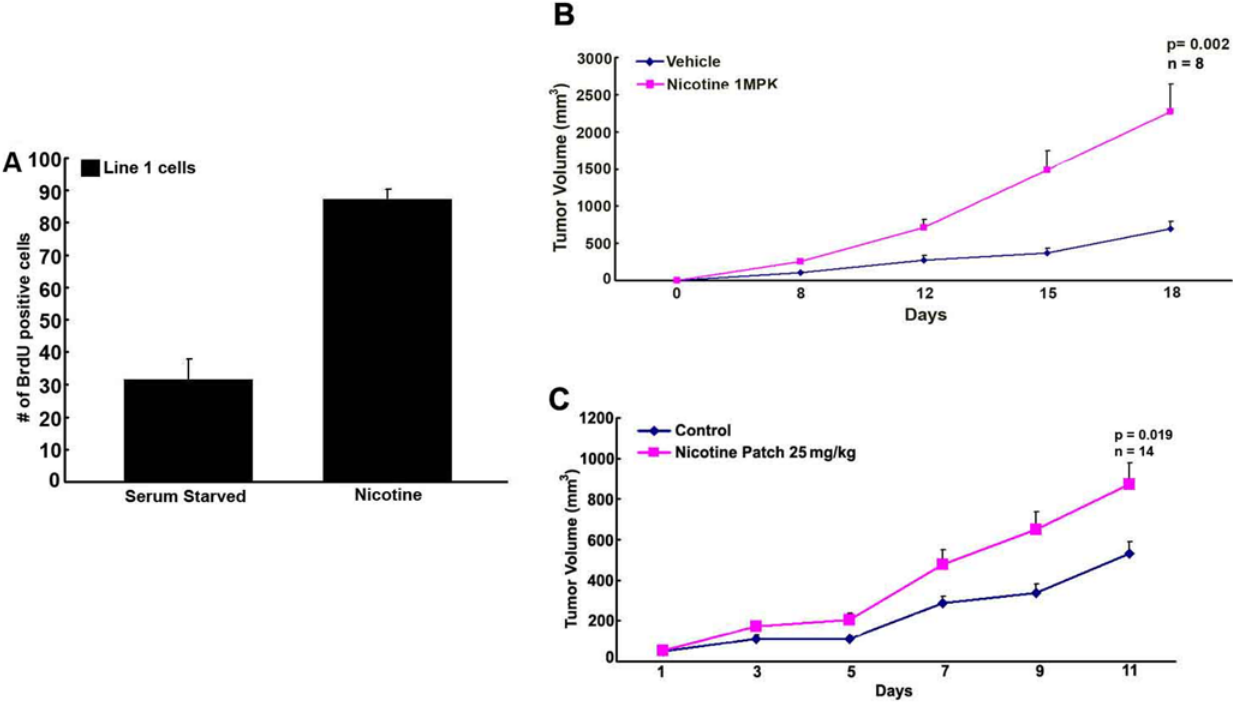
Figure 1. Nicotine promotes thegrowthofLine1 cells. (A) Nicotine (1 m M) promotes S-phase entry of serum starved Line1cells inBrdUincorporation assays. (B) Nicotine (1 mg/kg) significantly increases Line1 tumor growth in Balb/c mice when administered by i.p. injection thrice weekly, p=0.002, n=10. (C) Nicotine (25 mg/kg/daily) also significantly increases Line1 tumor growth when administered by transdermal patches p=0.019, n=14.